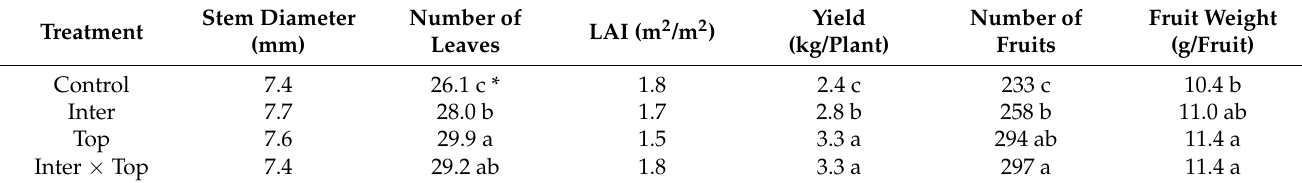
Table 1. Morphological and fruit changes in cherry tomato grown under different supplemental lighting